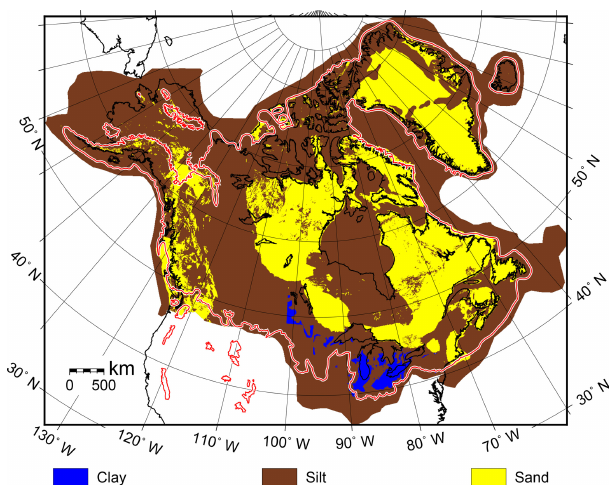
Figure 5. Sediment grain size. The red line is the glacial limit dur- ing the Last Glacial Maximum, 21000yrBP (Dyke, 2004). The types of sediment include clay (dominantly fine-grained sediment), silt (an average composition between sand and clay) and sand (dom- inantly coarse-grained